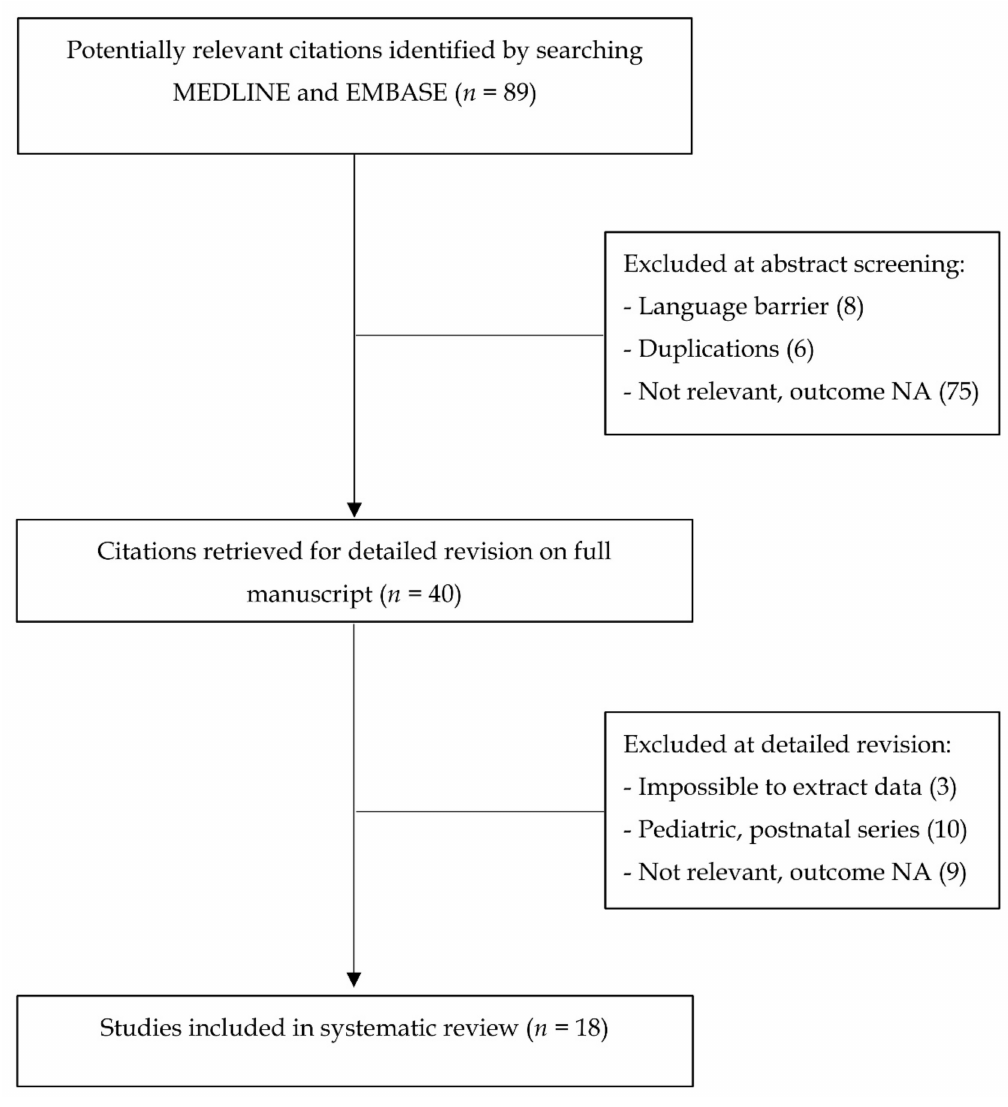
Figure 1. Flow chart of study design. NA: not